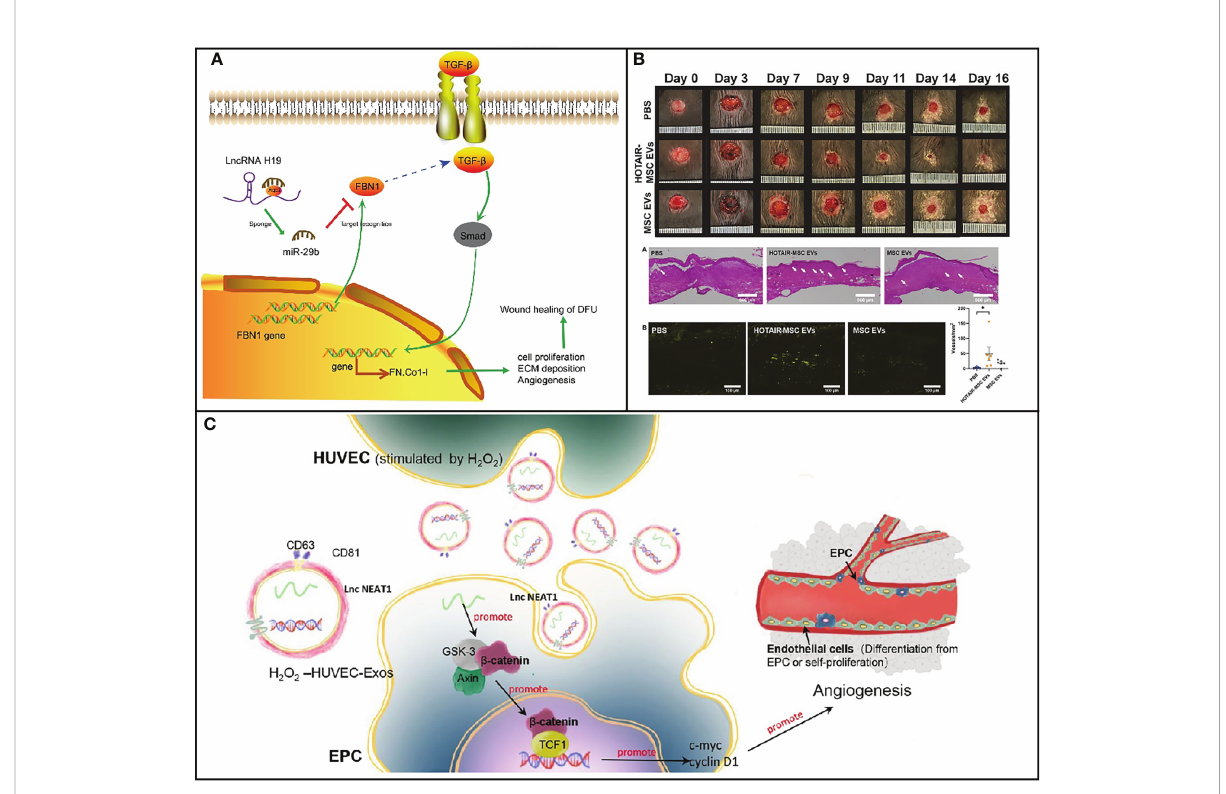
FIGURE 3 (A) Map of molecular mechanisms involved in lncRNA H19 modulation in wound healing of DFU by binding to miR-29b to regulate FBN1 expression [Adapted from Li et al., doi: 10.1096/fj.201900076RRRRR, (49)]. (B) HOTAIR-MSC EVs improve wound healing in db/db mice via increasing angiogenesis [Adapted from Born et al., doi: 10.1002/adhm.202002070, (50)]. (C) Schematic illustration of the function and mechanisms of HUVEC-Exos on EPCs [Adapted from Guo et al., doi: 10.1186/s13287-022-03013-9, (51)]. *p <